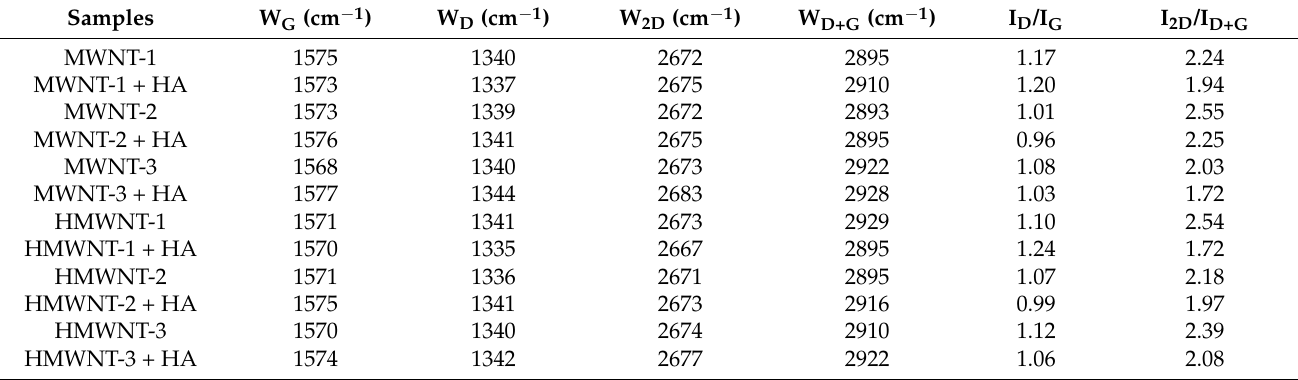
Table 4. Raman parameters of MWNTs and HMWNTs prior to and after HA